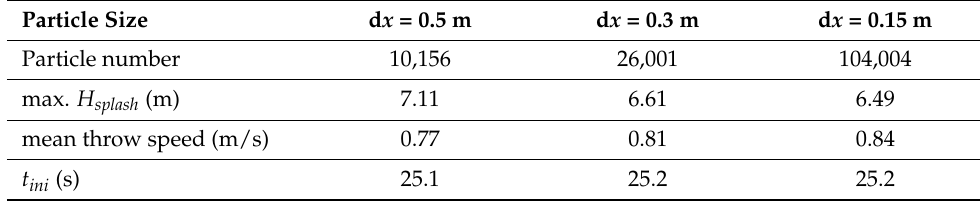
Table 1. Results of the convergence study for SPH simulation by presented SPH model.